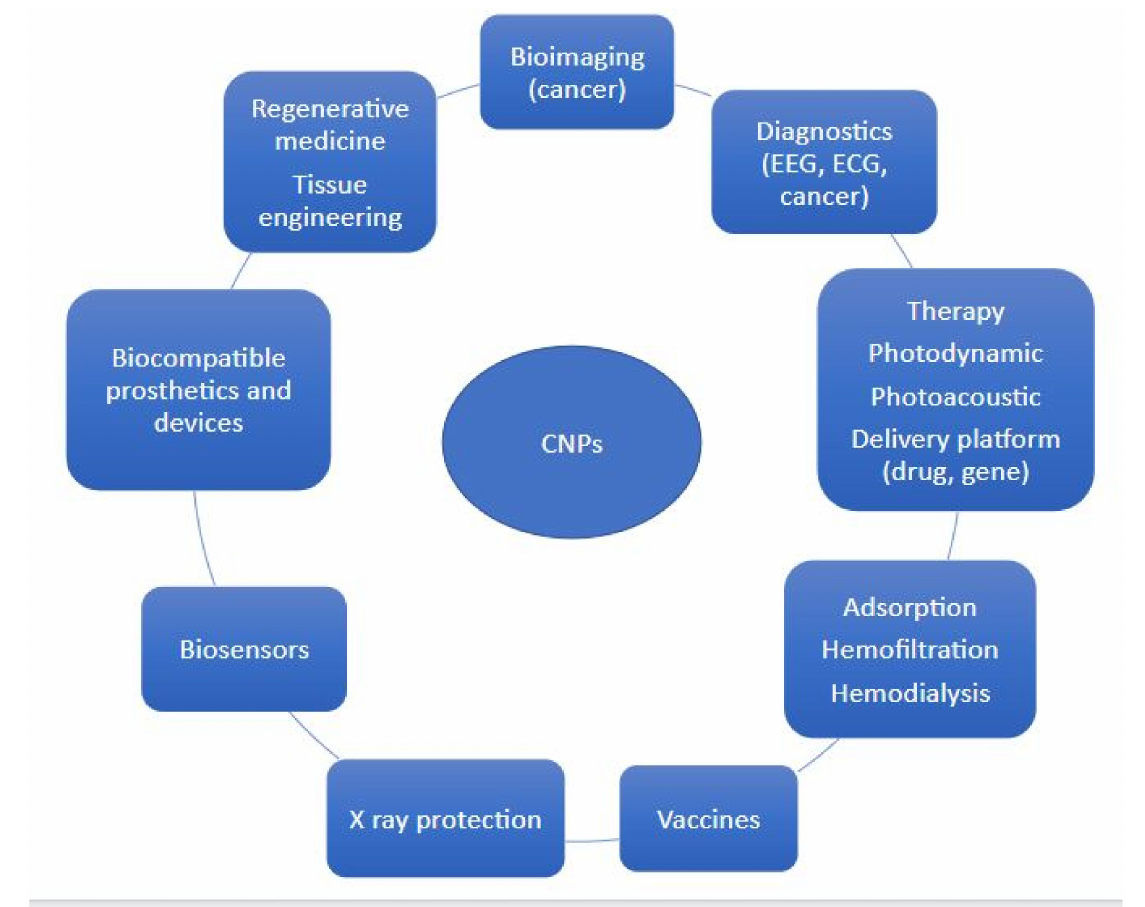
Figure 2. Application of